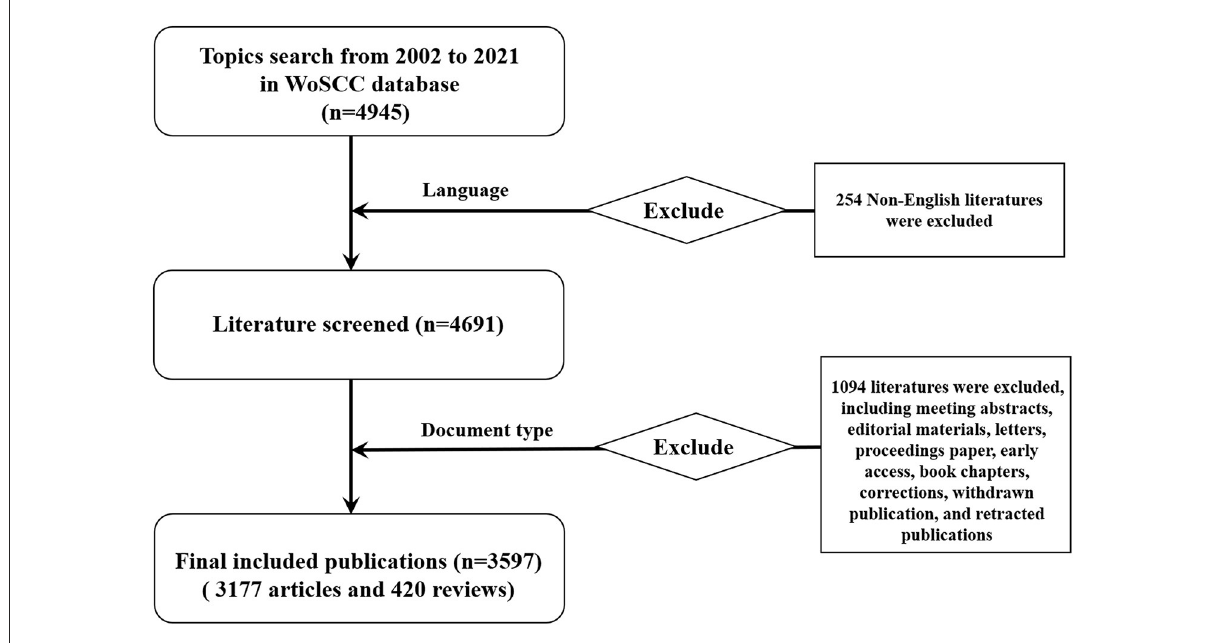
FIGURE1 The flowchart of data